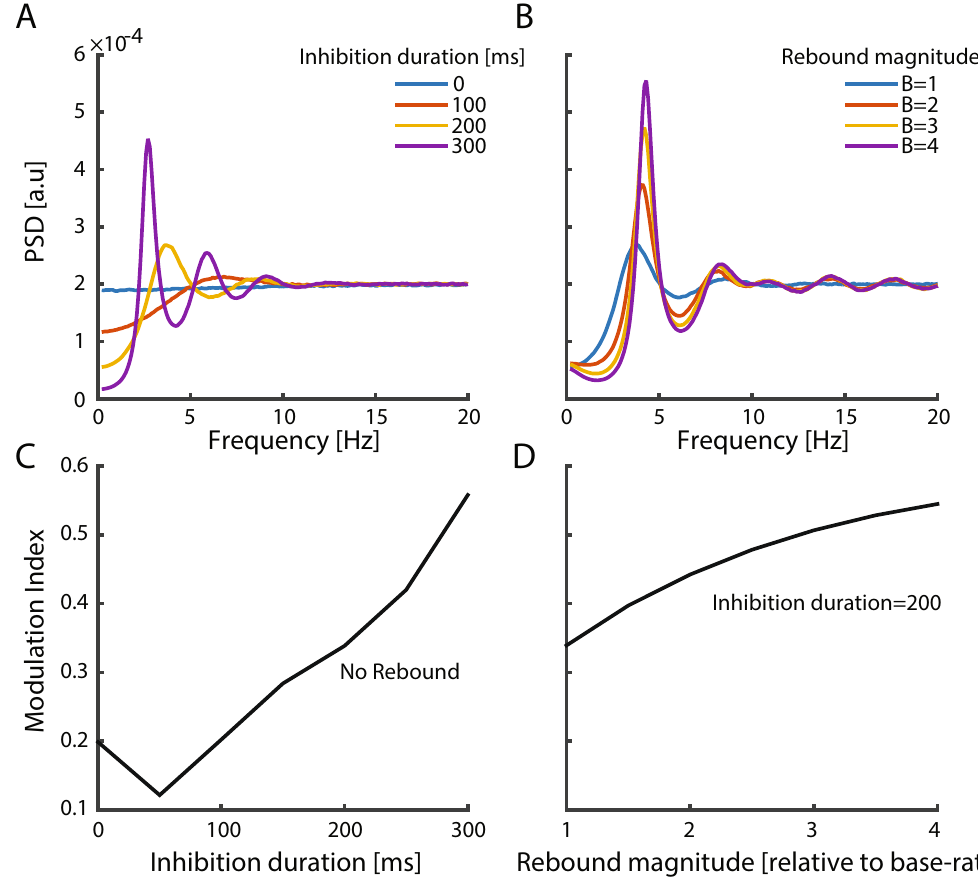
Figure 5. Effects of first-order model parameters on spectra and modulation indices. PSD ( A ), and modulation index ( C ), modulated by the duration of inhibition (rebound is fixed at 0). PSD ( B ) and modulation index ( D ) modulated by the magnitude of rebound (duration of inhibition is fixed at 200 ms).